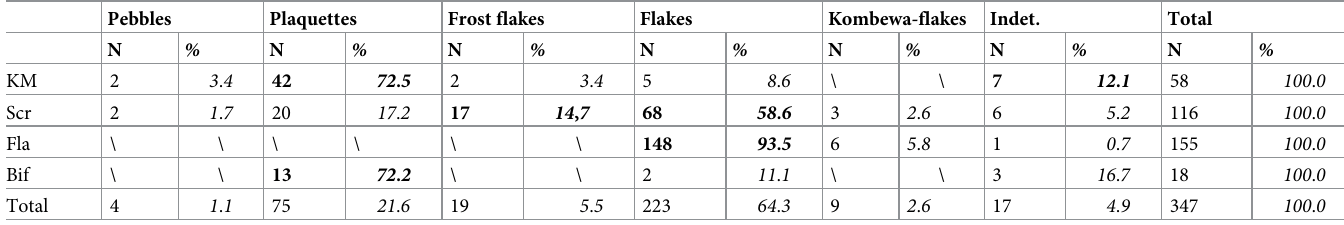
Table 4. Raw blank for techno-typological category of tools.